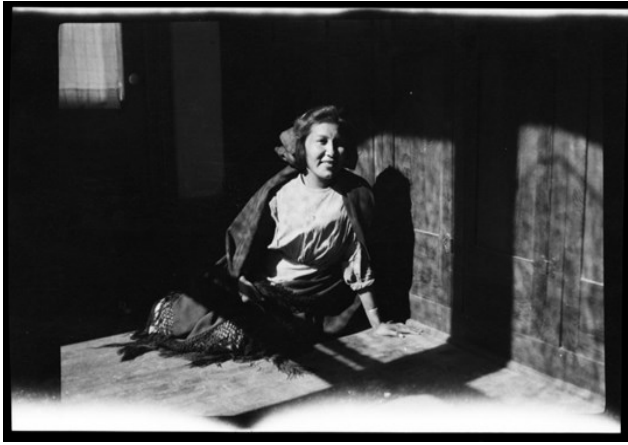
Figure 14. Nettie Odlety, Inside the Girls’ Dormitory—Phoenix Indian Boarding School, c. 1915. Parker McKenzie Collection. Courtesy of the Oklahoma Historical Society.